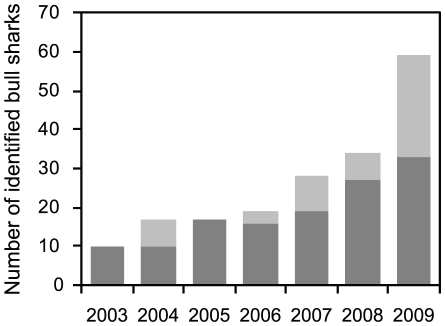
Number of individually identified C. leucas from
2003 to 2009.Dark grey bars denote the number of identified sharks at the beginning of
the respective year; light grey bars denote the number of individuals
added to the list during the respective year.